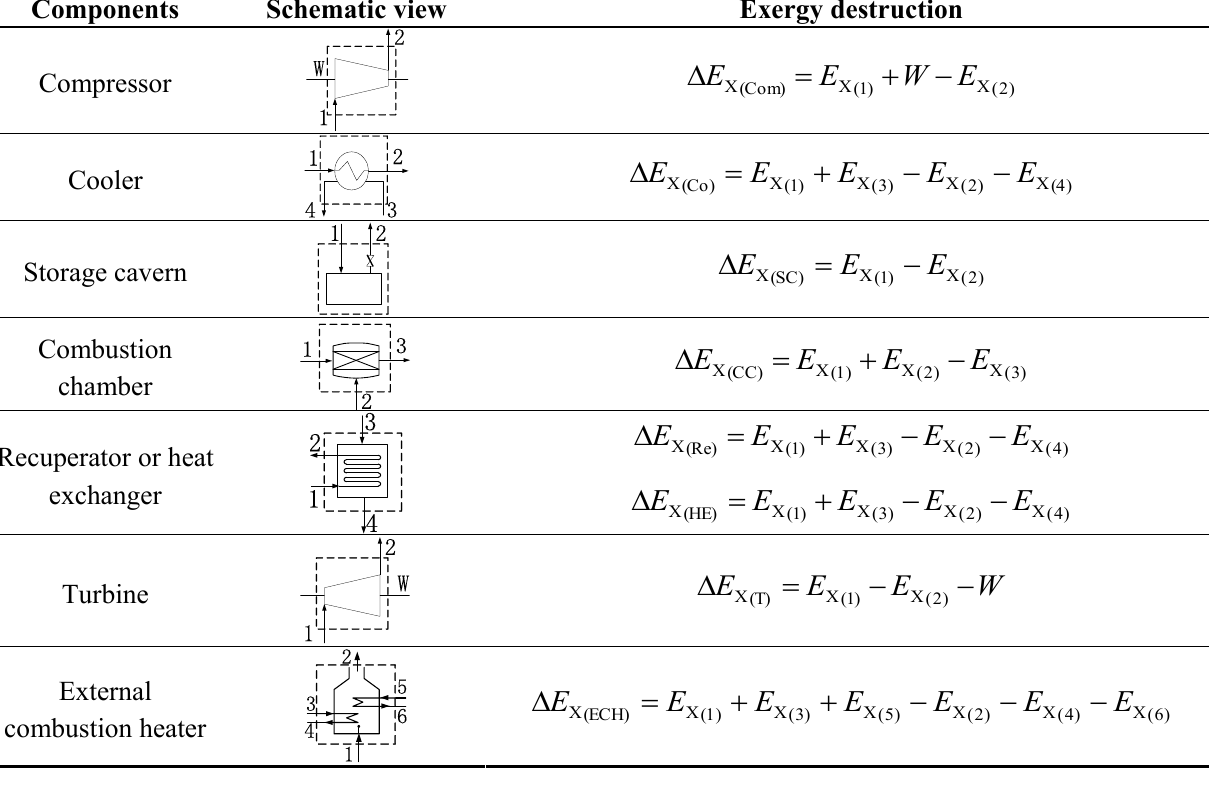
Table 5. Expression of exergy destruction in the main components of the